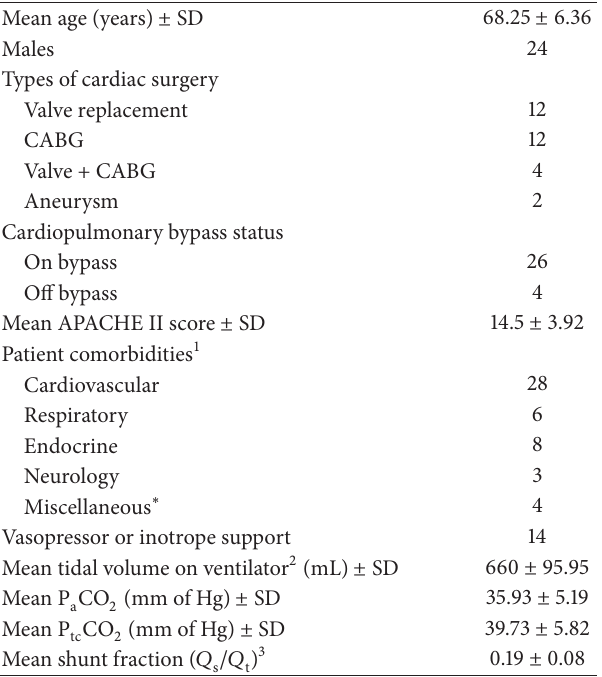
Table 1: Patient demographic and clinical characteristics ( 𝑛 = 30